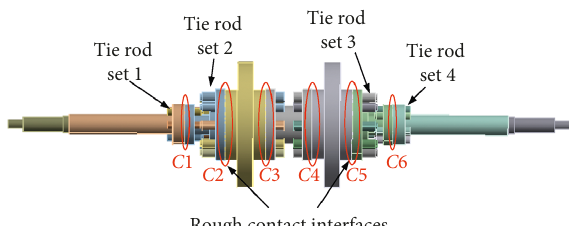
Figure 3: The rough contact interfaces of the experimental rod-fastened